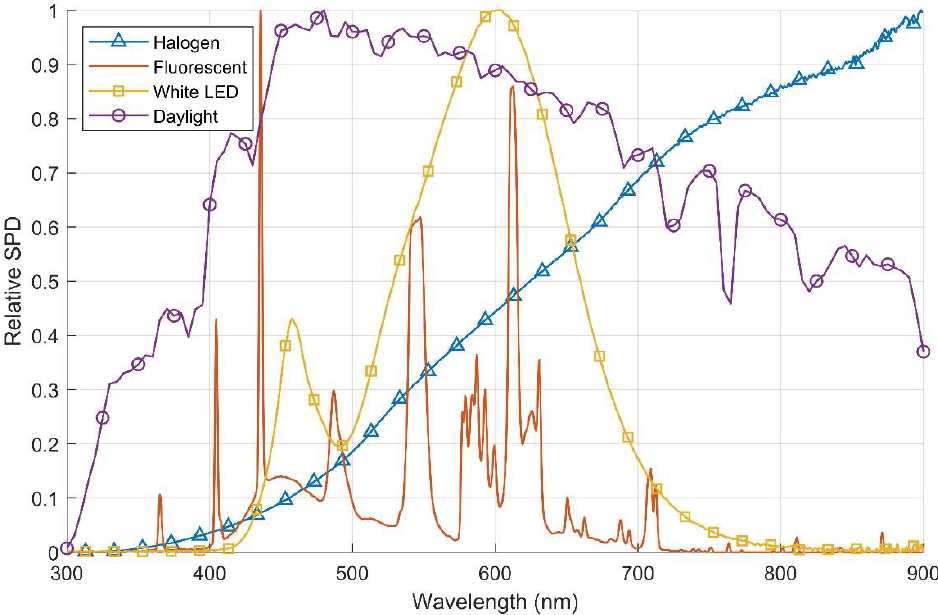
Figure 3. Relative spectral power distribution of some common light sources.